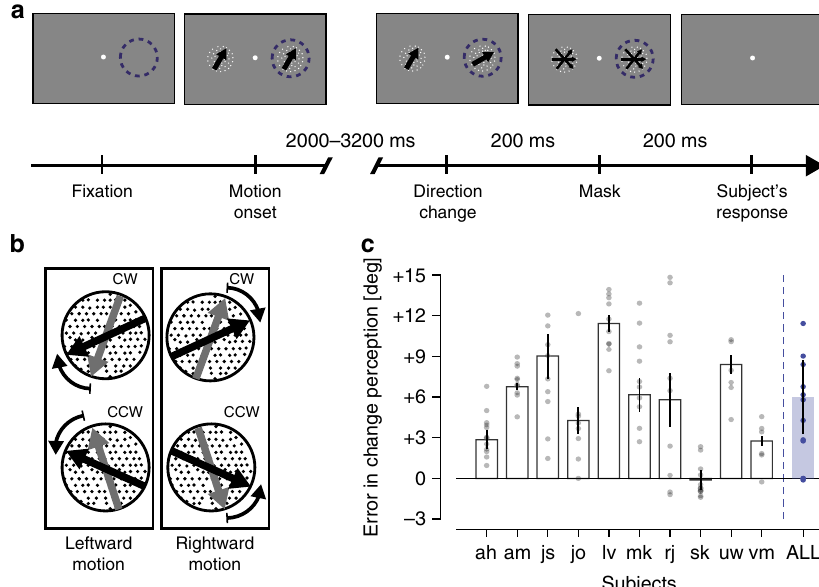
Fig. 3 Quantifying the perceived magnitude of attended direction changes in humans. a Subjects had to foveate a central fi xation point (white dot), covertly attend to the right side of the screen (dashed circle) and press a gamepad button to start a trial. Then, two coherent RDPs moving in the same direction were displayed. At a random time between 2000 and 3200 ms after motion onset, a direction change of 22°, 25°, or 27° occurred in the right stimulus. 200 ms later, the RDPs were replaced by two mask RDPs displayed for 200 ms. The subjects had to report whether the post-change motion direction was upward or downward from horizontal (see Methods). b Stimulus con fi guration in the psychophysical task. In a given trial, RDPs could move either leftward or rightward. For each motion direction, one of two clockwise (CW) and counterclockwise (CCW) direction changes could occur. Gray and black arrows indicate pre- and post-change motion directions, respectively. c Error in direction change perception: subject codes are shown along the abscissa (last bar: median effect across all n = 10 subjects) and the ordinate represents the median error in the perceived direction change. According to our sign convention, positive and negative errors along the y -axis correspond to an overestimation and underestimation of a direction change, respectively. Filled circles show the data points underlying each bar in the graph and error bars indicate the median absolute deviations. Source data are provided as a Source Data fi two RDPs moving in the same direction (rightward or leftward, with some deviation off the horizontal) were presented to the left and right of the fi xation spot and subjects were instructed to attend to the right RDP. At a random time point the direction of